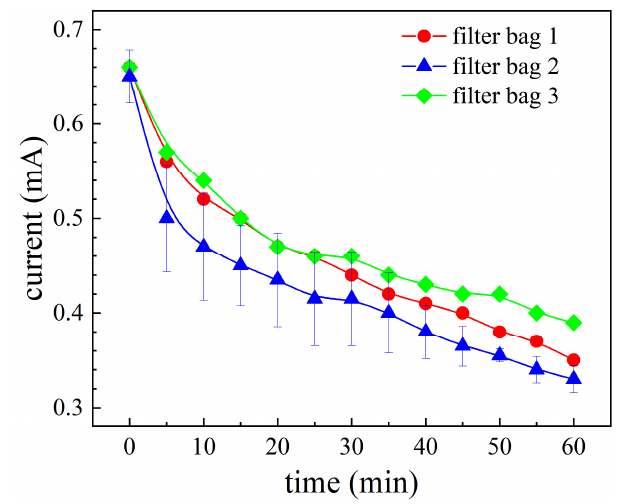
Figure 9. Variation in current of the hybrid electrostatic precipitators with different fiber bags.